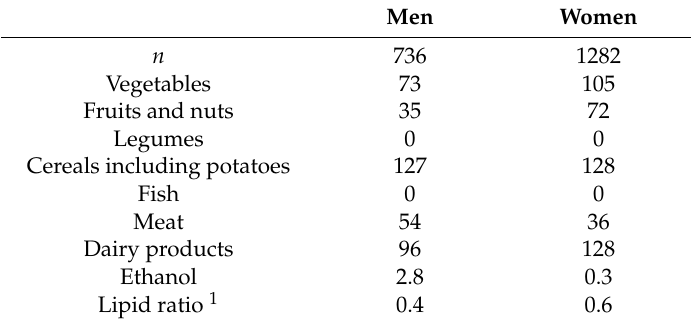
Table 1. Median daily consumption in grams per 1000 kcal per day for the nine components of the Modified Mediterranean Diet Score.